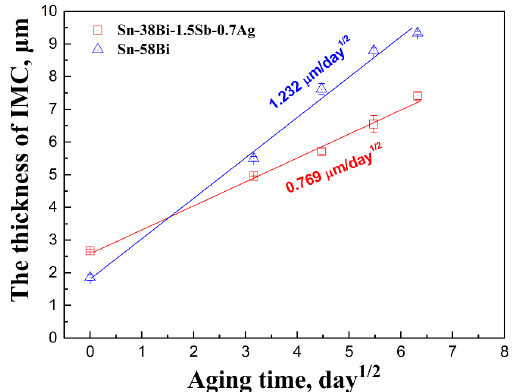
Figure 5. Relationship between the thickness of interfacial intermetallic compound (IMC) and aging duration.